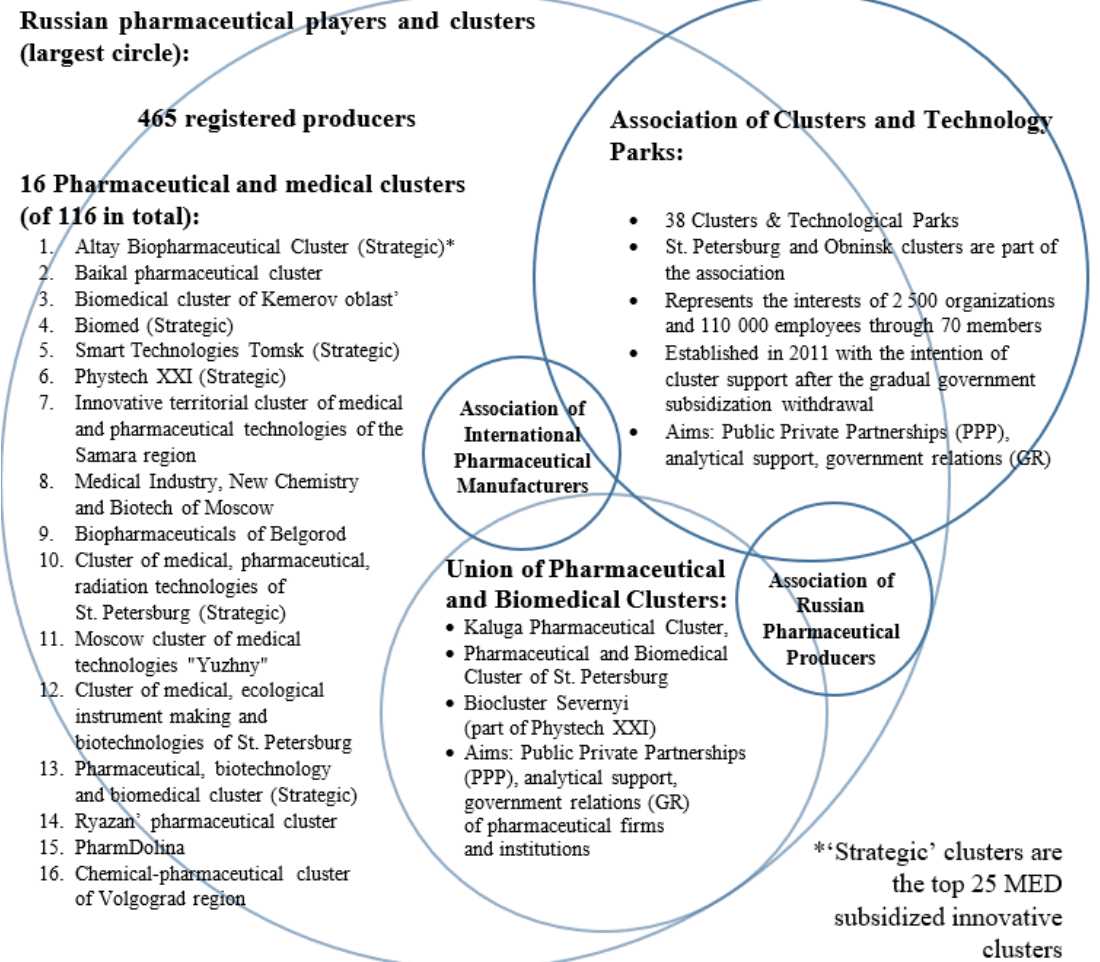
Figure 1. The networks of Russia’s pharmaceutical clusters, firms and associations. Sources: Association of Clusters and Technology Parks (2017); Association of Russian Pharmaceutical Producers (2016); Ministry of Economic Development of Russia (2012); National Research University—Higher School of Economics (2018).